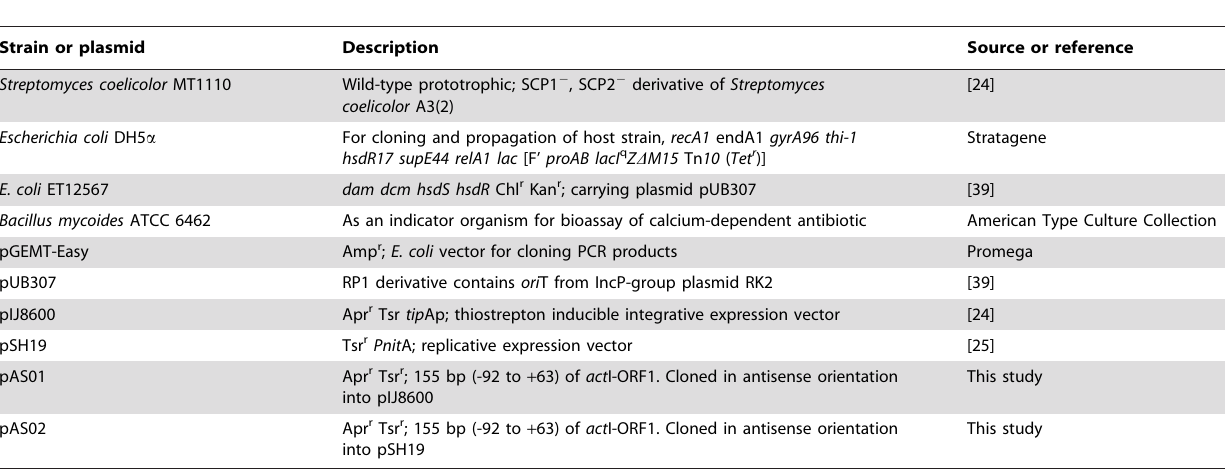
Table 1. Bacterial Strains and plasmids used in this study.